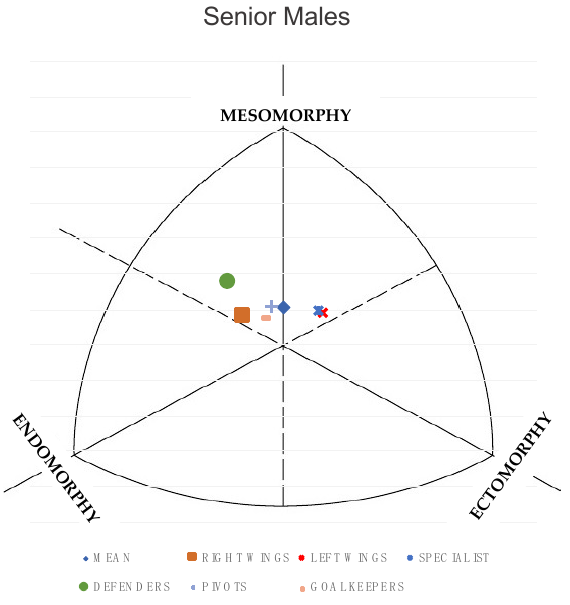
Figure 1. Somatotype distribution of elite male junior handball players.